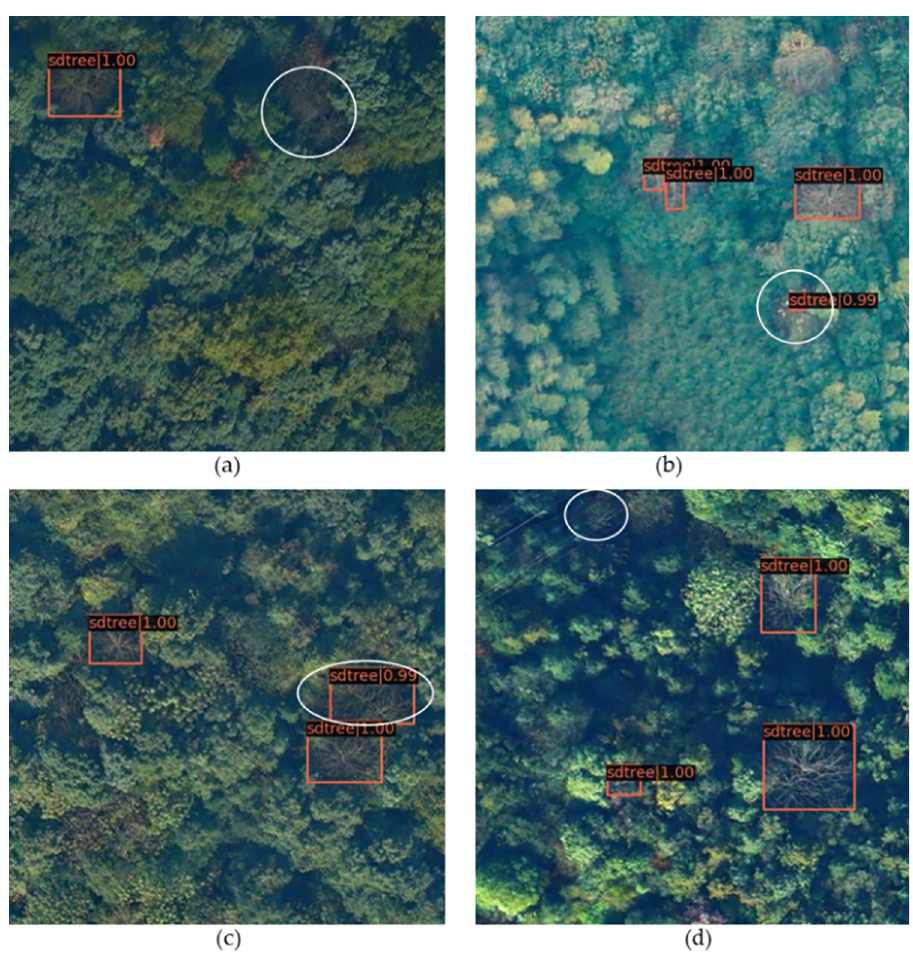
Fig 11. Errors in the improved algorithm.